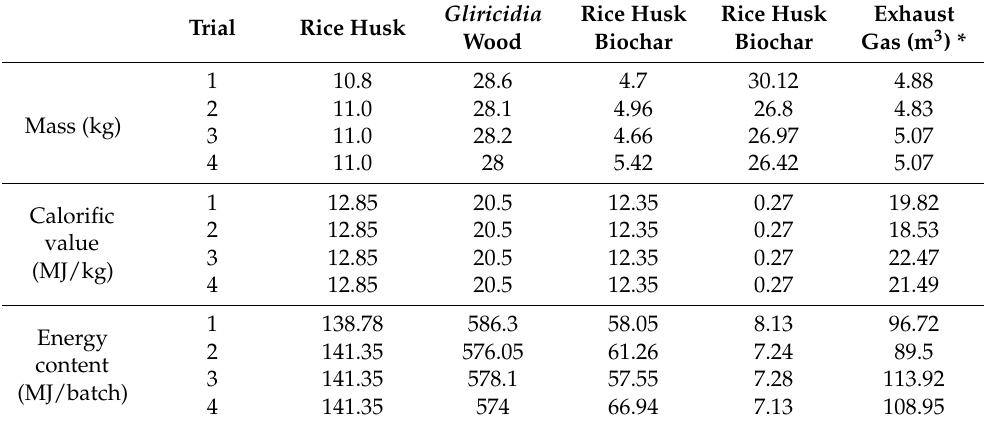
Table 5. Energy values for each biomass material in the pyrolysis process for the different trials.